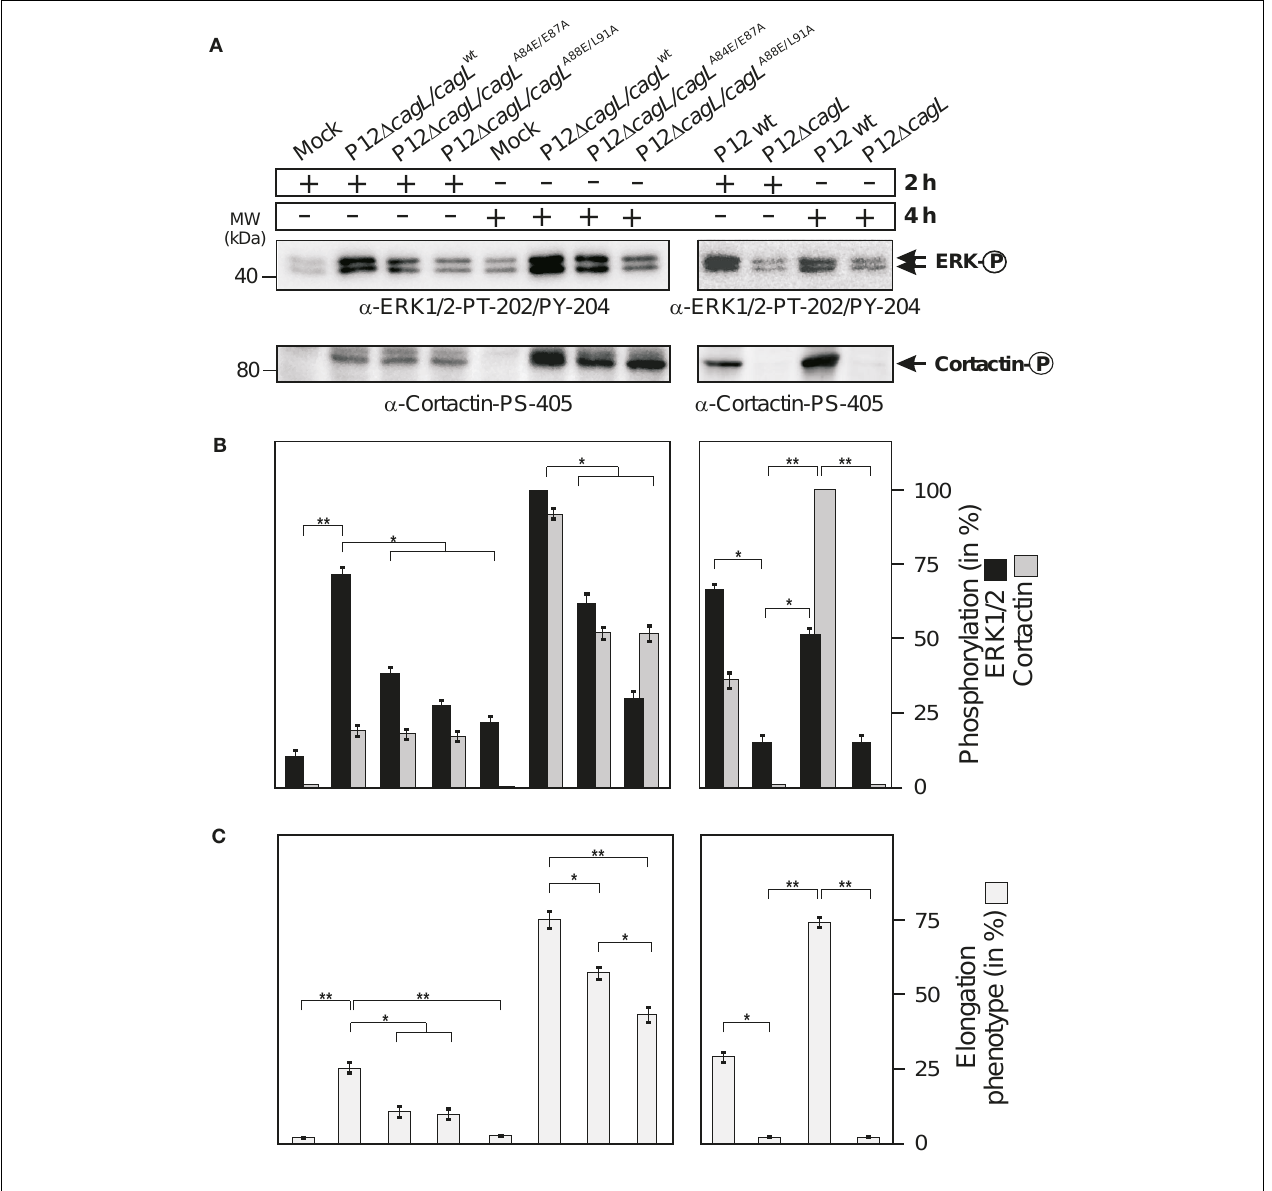
(B) Densitometric measurement of individual band intensities of the blots in (A) and comparison to total α -ERK1/2 and α -cortactin blots (not shown) was performed with the Lumi-Imager F1 (Roche).The relative amounts of phospho-ERK1/2 and phospho-cortactin per sample were quantified and given in%. (C) Quantification of the AGS cell elongation phenotype in the same set of experiments. Similar inhibitory activities of all mutants were seen when MOI = 50 was used (not